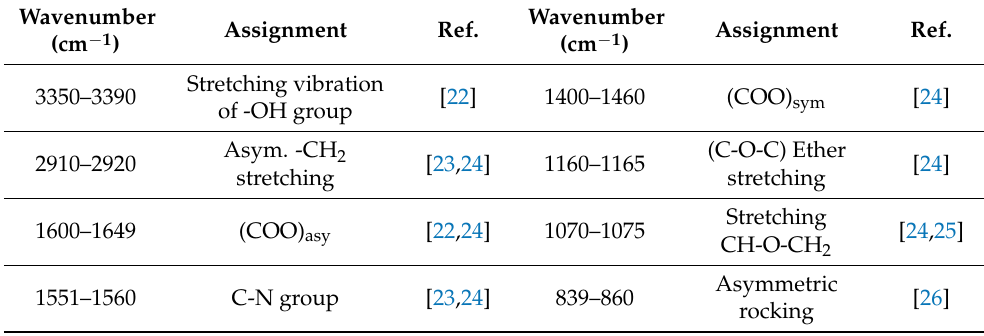
Table 1. Peak positions and vibration modes in CMC/GEL/ZnO nanocomposites hydrogels.